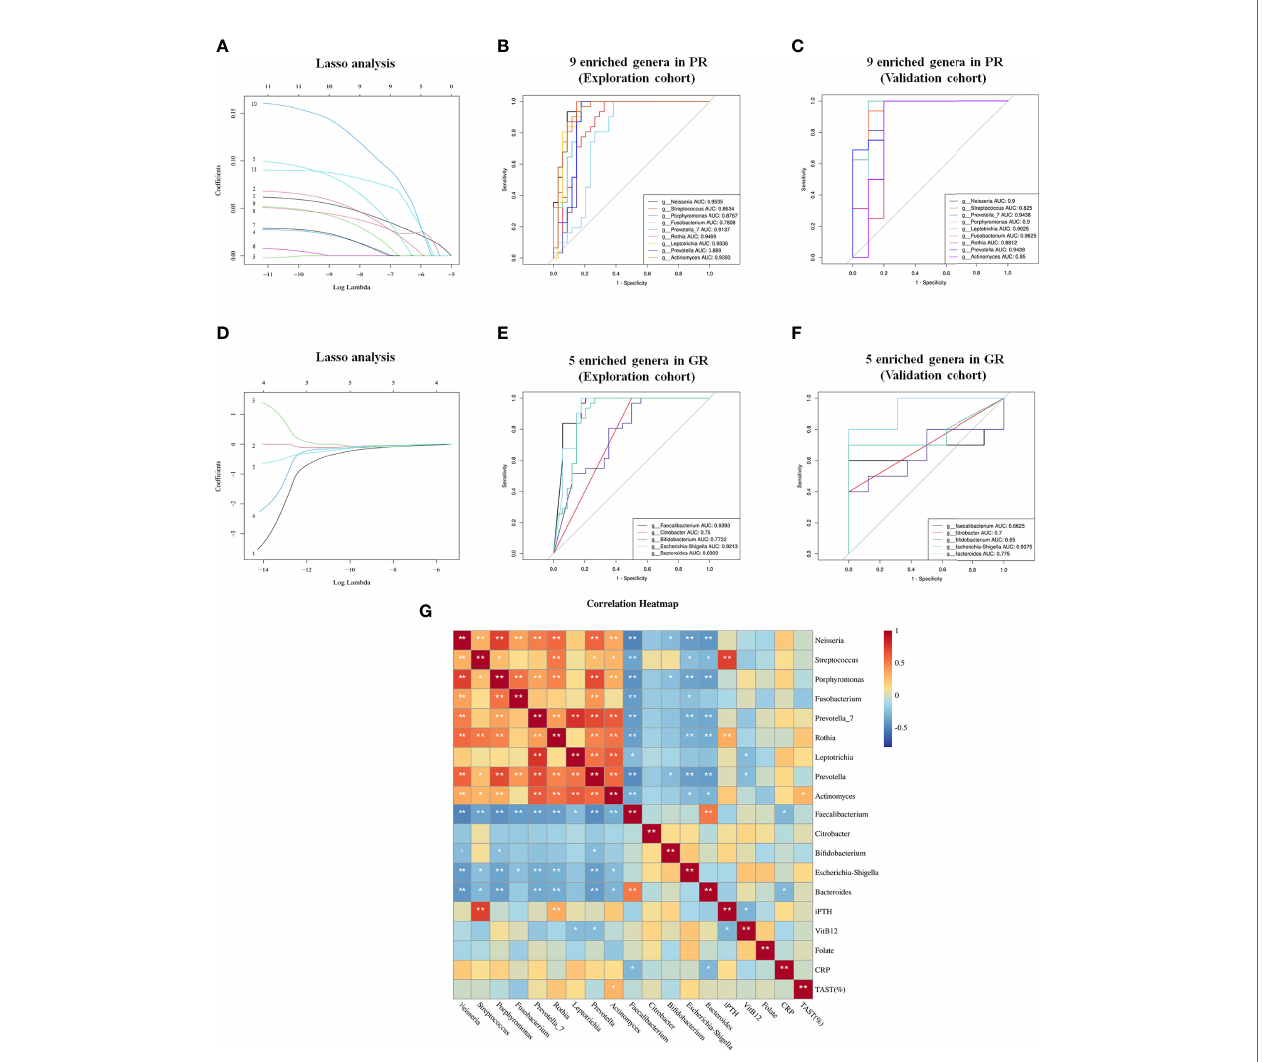
FIGURE 5 | Lasso regression model and ROC to further identify biomarkers to distinguish GR from PR. (A) Lasso regression model of 11 genera fi ltered from LEfSe analysis; 1, g:Neisseria 2, g: Streptococcus 3, g:Haemophilus 4, g:Porphyromonas 5, g:Fusobacterium 6, g:Veillonella 7, g:Prevotella_7 8, g:Rothia 9, g:Leptotrichia 10, g:Prevotella 11, g:Actinomyces . (B, C) ROC curves of nine Lasso-selected genera in the exploration and validation cohorts with P < 0.05. (D) Lasso regression model of fi ve genera enriched in GR fi ltered from LEfSe analysis. 1, g:Faecalibacterium 2, g:Citrobacter 3, g:Bi fi dobacterium 4, g:Escherichia-Shigella 5, g: Bacteroides . (E, F) ROC curve of fi ve Lasso-selected genera in exploration and validation cohort with P < 0.05. PR, poor response; GR, good response. (G) Correlation analysis between biomarkers and potential indicators associated with EH. * p < 0.05; ** p <